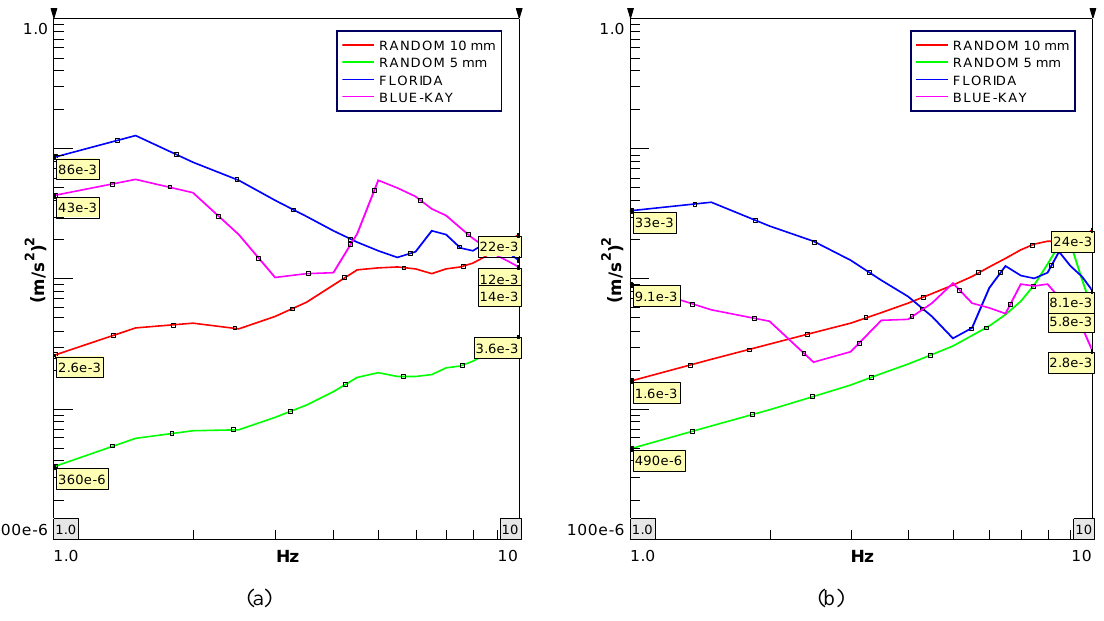
Fig. 4. Comparison of the driver seat rail output auto-power spectrum in the four poster test cases reported in the legend and for (a) the semi-active suspension equipped car and (b) the active suspension equipped